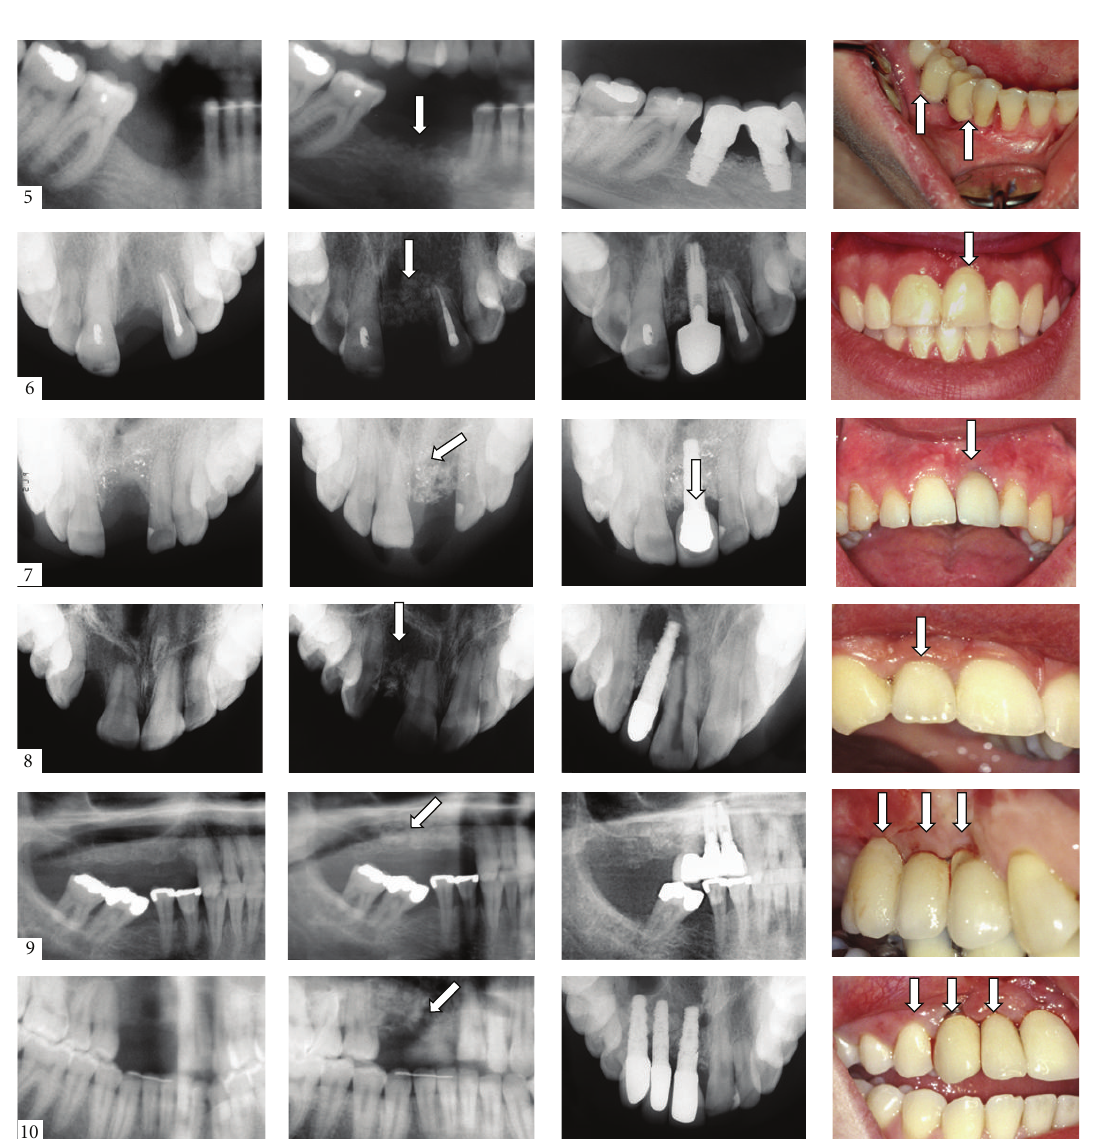
Figure 5: Overview for patients 5–10 from the study by Meijer et al. to reconstruct a maxillary defect and placement of dental implants. First column; radiographs showing the alveolar defects. Second column; showing the reconstruction (arrow) by augmentation (5–8) and by sinus elevation procedure (9 and 10). Third column; radiographs showing the dental implants and the prosthetic construction (crown or bridge). Fourth column; clinical situation at the end of the rehabilitations